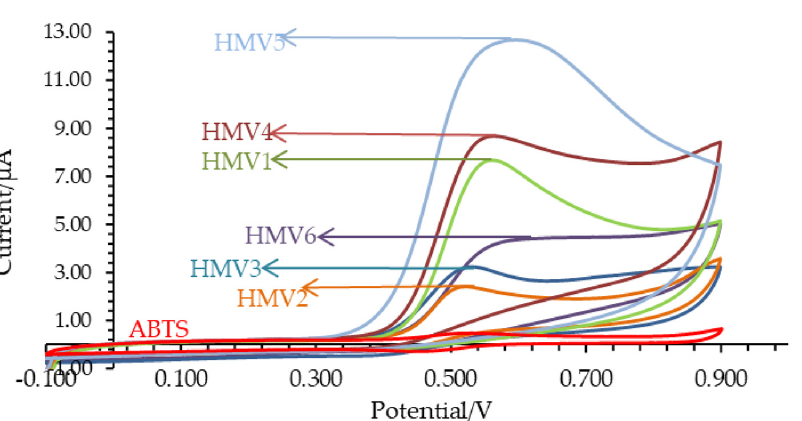
Figure 6. Cyclic voltammograms of homemade vinegars (HMV) after 2 months of fermentation process in relation to the cyclic voltammogram of ABTS (red curve): apple vinegar (HMV1); raspberry vinegar (HMV2); blueberry vinegar (HMV3); blackberry vinegar (HMV4); rose hip vinegar (HMV5); persimmon vinegar